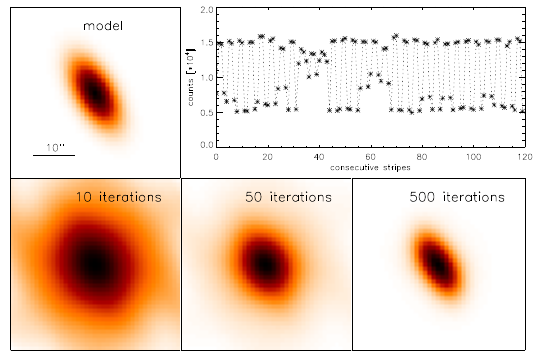
Figure 8. Example of the simulated source (top left panel) and corresponding counts measured in stripes (right panel). Bottom row presents reconstruction with RL algorithm for 10, 50 and 500 steps of iteration.(see text for further